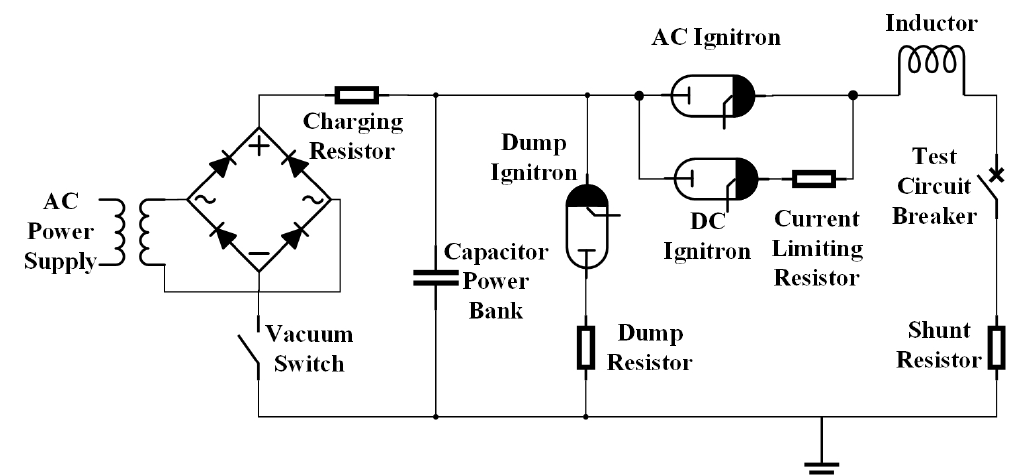
Figure 2. Schematic diagram of test circuit.